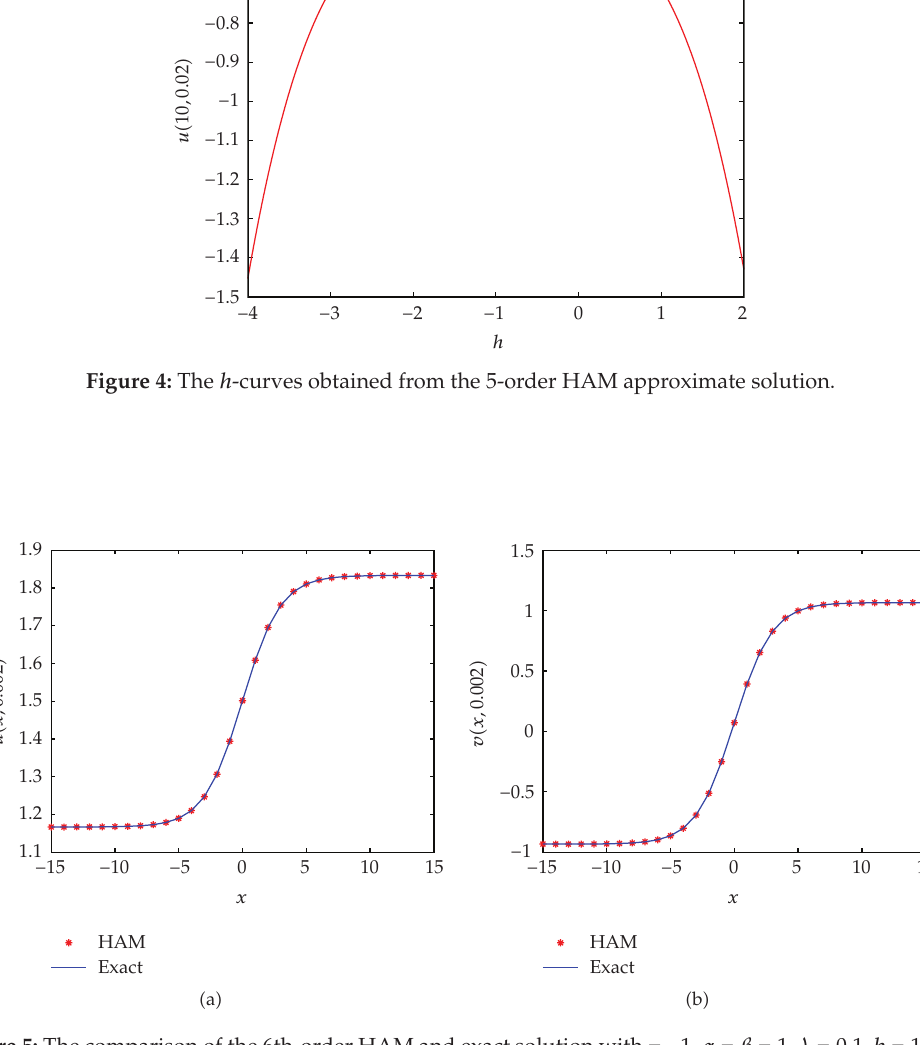
Figure 5: The comparison of the 6th-order HAM and exact solution with (cid:8) − 1, α (cid:8) β (cid:8) 1, λ (cid:8) 0 . 1, b (cid:8) 1, and k (cid:8) 1 /